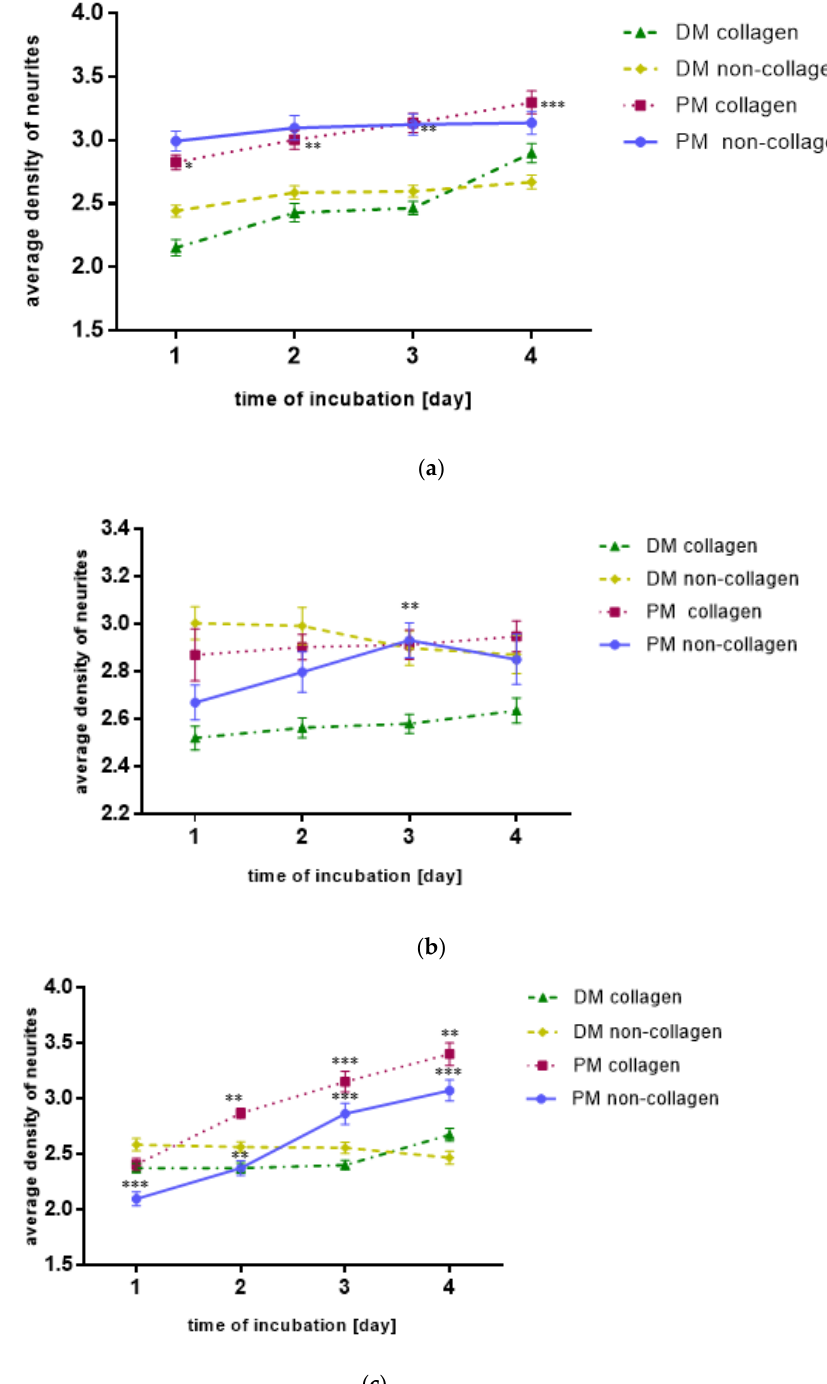
Figure 2. ( a ) The influence of the medium type and the addition of collagen on neurites density of SH-SY5Y cells. Results are presented as mean values ± SD. Differences vs the previous day *** p < 0.001; ** p < 0.01 were deemed statistically significant. ( b ) The influence of vibration with frequency of 40 Hz, the medium type and the addition of collagen on neurites density of SH-SY5Y cells. Results are presented as mean values ± SD. Difference vs. the 1st day ** p < 0.01 was deemed statistically significant. ( c ) The influence of vibration with frequency of 100 Hz, the medium type and the addition of collagen on neurites density of SH-SY5Y cells. Results are presented as mean values ± SD. Differences vs the previous day *** p < 0.001; ** p < 0.01 were deemed statistically significant.